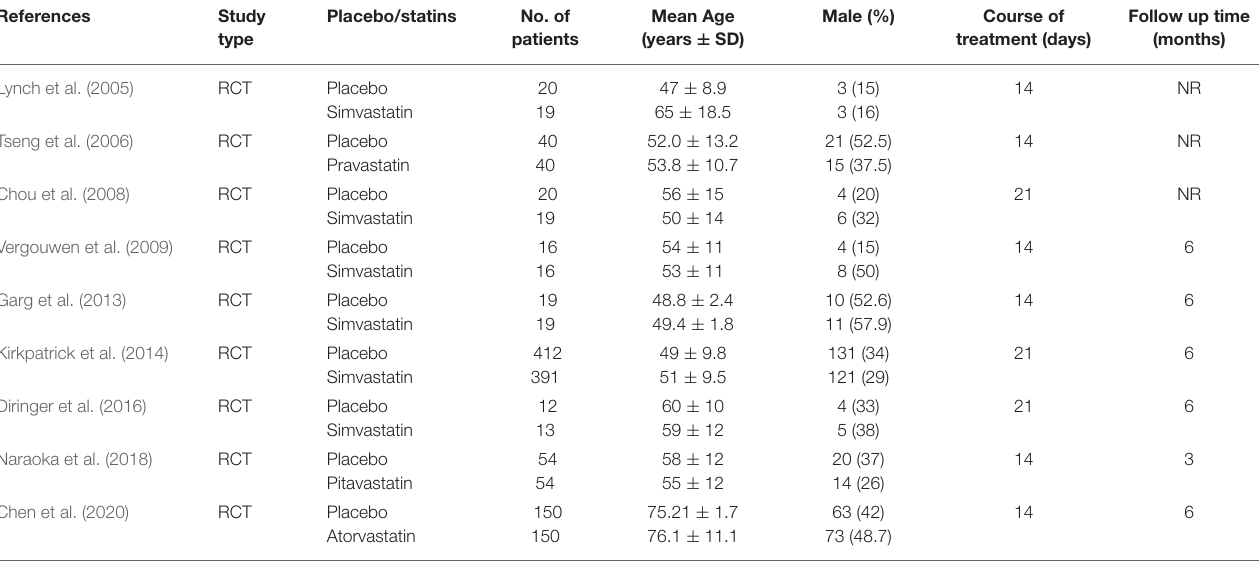
TABLE 1 | Characteristics of studies included in the systematic